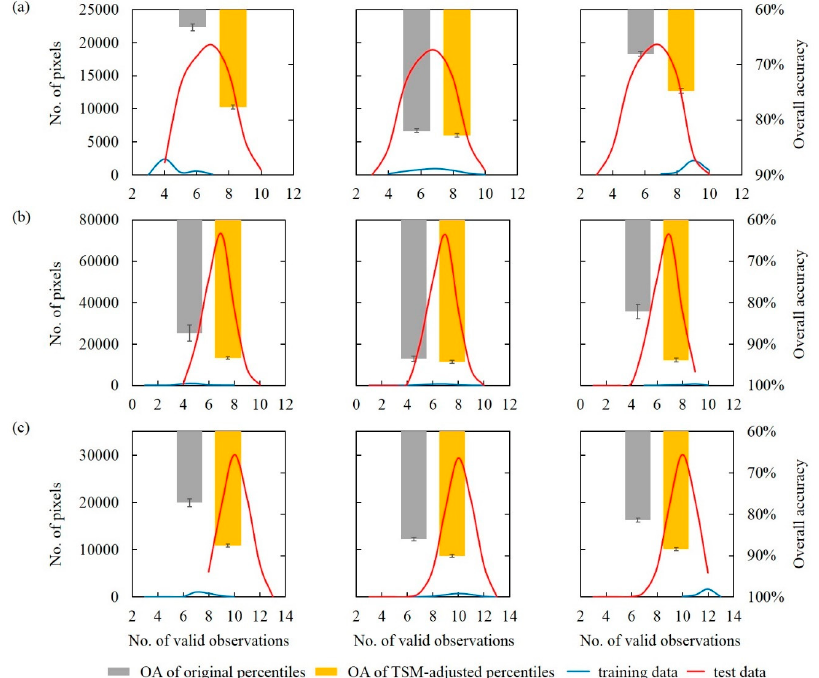
Figure 13. Sensitivity of the overall classification accuracy to different sampling strategies of training data in Minnesota ( a ), Iowa ( b ), and New York ( c ) study area. Left column: random sampling of training pixels limited to locations with low observation frequencies. Middle column: random sampling across valid observation frequency stratums for each class (used in this paper). Right column: random sampling of training pixels limited to locations with high observation